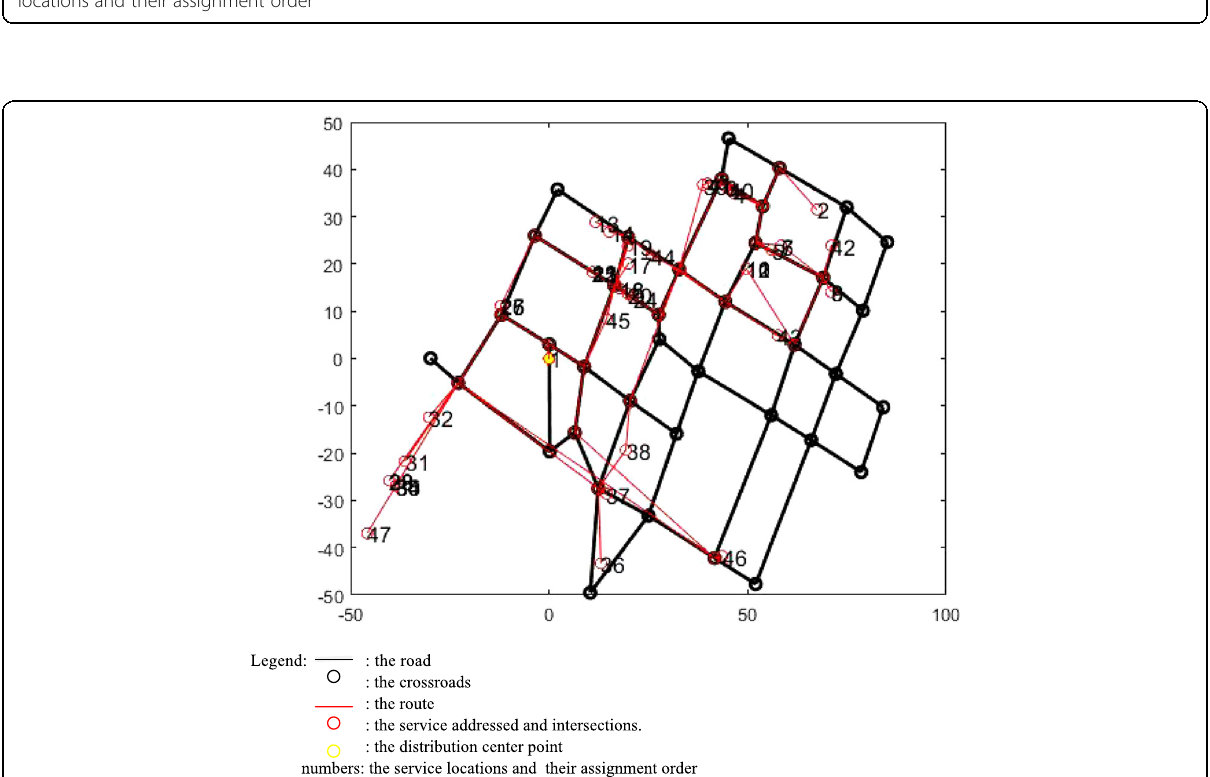
Fig. 3 Planning route 2. Black line represents the road, black circle represents the crossroads, red line represents the route, red circle represents the areas the service addressed and intersections, yellow circle represents the distribution center point, and numbers represent the service locations and their assignment